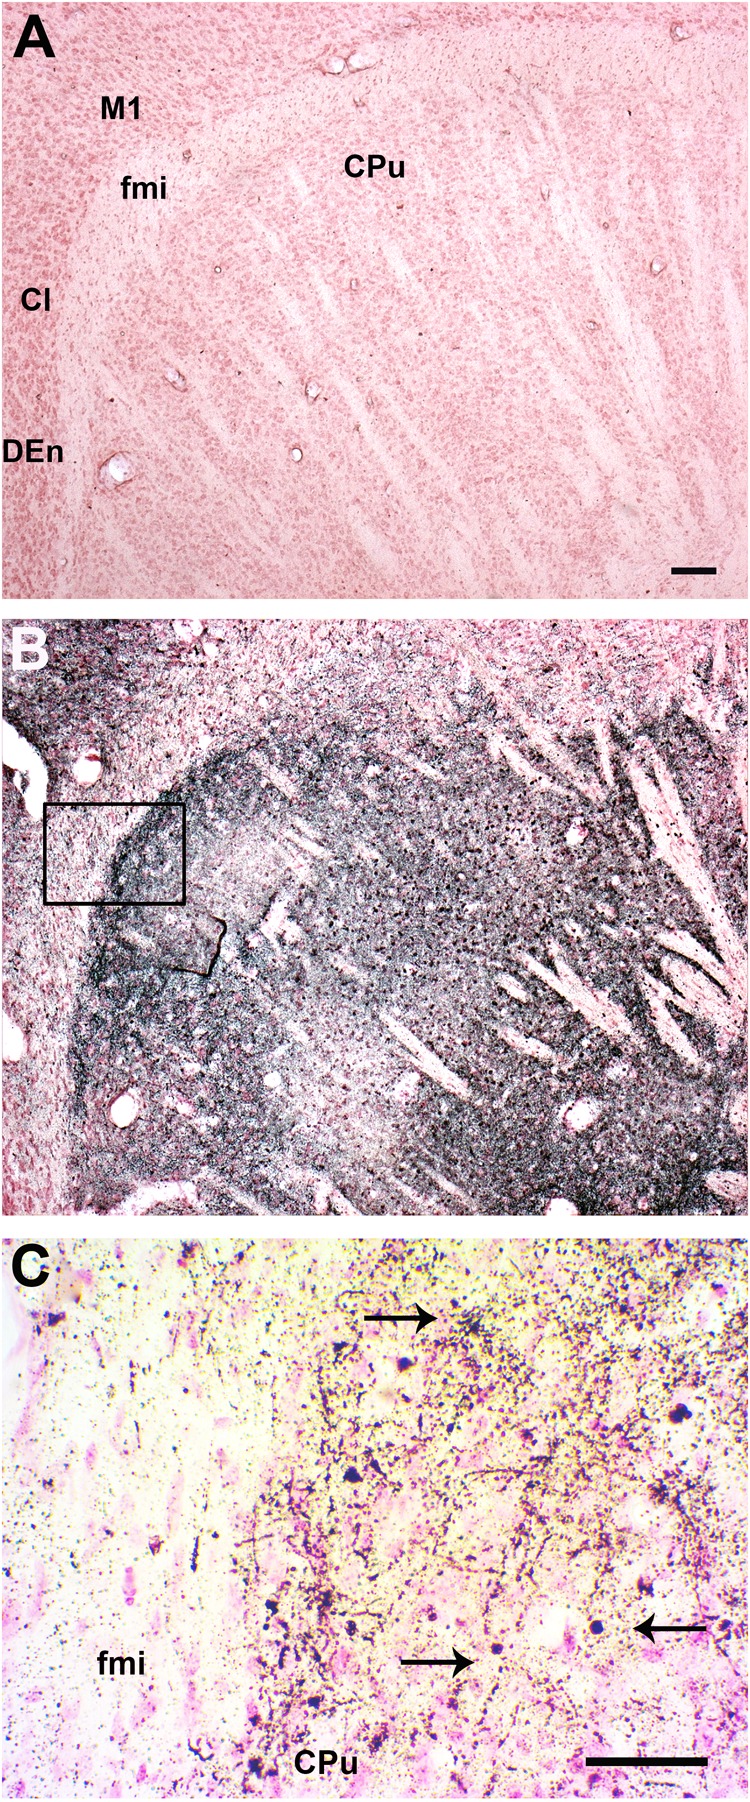
Infection with SLEV CbaAr-4005 induced degeneration in the Caudate Putamen. Compared to the brain of uninfected mice (A), a remarkable increase in the density of A-Cu-Ag stained fibers was clearly observed in the striatum, along with clusters of apoptotic-like cells and even occasional somatodendritic degeneration in mice sacrificed at day 11 PI (B). An augmented detail of the area affected by apoptotic-like degeneration (inset in B) is shown in (C); black arrows indicate A-Cu-Ag stained cells. Sagittal sections Lat.3.4, Bar = 100 μm. This figure is representative of three independent experiments. M1, primary motor cortex. fmi, forceps minor of the corpus callosum. CPu, caudate putamen (striatum). CI, claustrum. DEn: dorsal endopiriform claustrum.